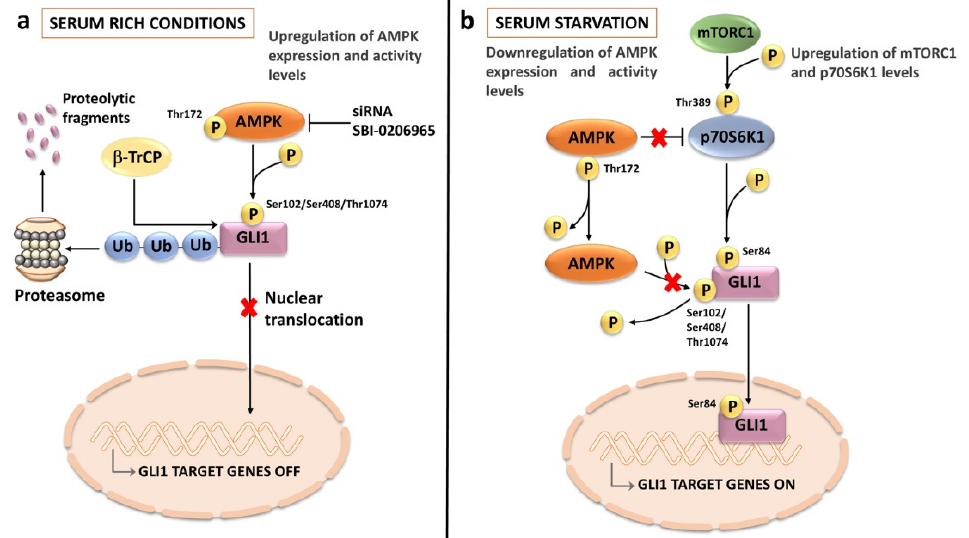
Figure 7. Interactions between AMPK and HH signaling pathways in T-ALL cells: ( a ) under serum- rich conditions, AMPK is overexpressed and active (i.e., phosphorylated at Thr172). Active AMPK phosphorylates GLI1 at multiple amino acid residues. This phosphorylation leads to GLI1 ubiquiti- nation by β -TrCP followed by proteasomal degradation; ( b ) when T-ALL cells are serum starved, AMPK expression and activity levels are downregulated, hence GLI1 is not phosphorylated at AMPK-dependent residues. In contrast, the mTORC1/p70S6K1 axis is overactive, due to AMPK inactivation/decreased expression. p70S6K1 kinase phosphorylates GLI1 at Ser84, thereby increasing the stability of GLI1 and enhancing its transcriptional activity. AMPK, AMP-activated protein kinase; β -TrCP, β -transducin repeat containing E3 ubiquitin protein